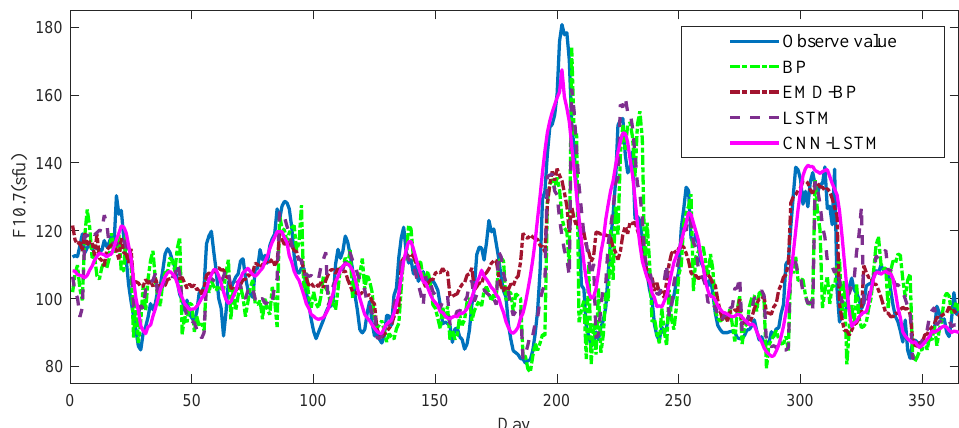
Figure 4. The fitting curves of 10-day forecasts in